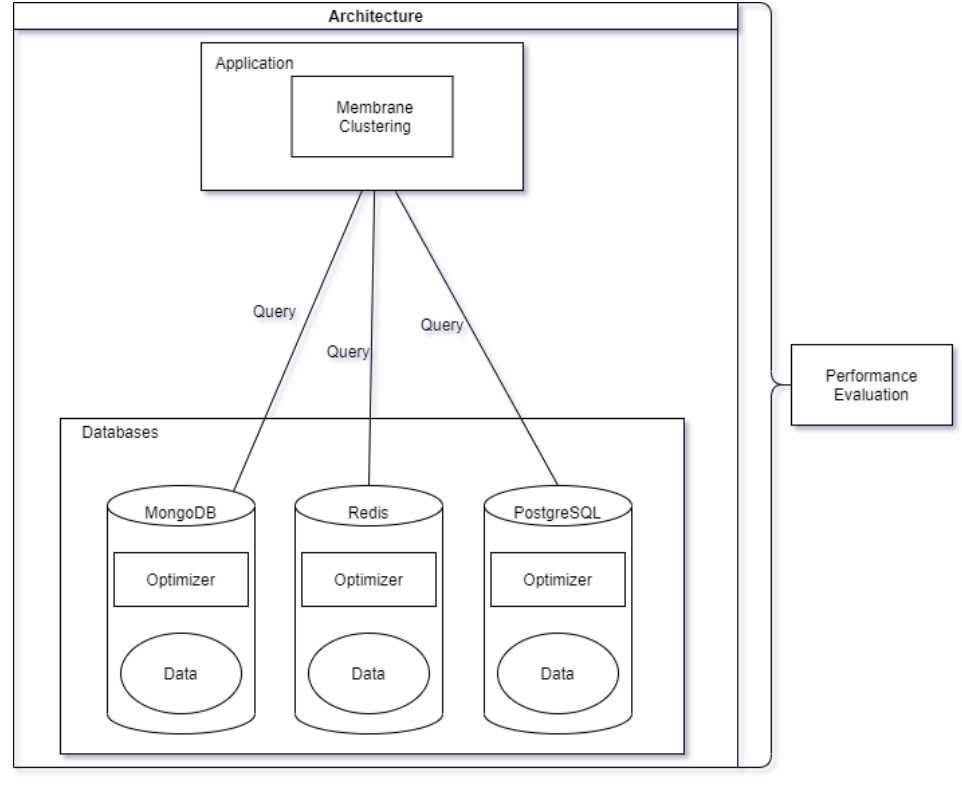
Figure 1. System